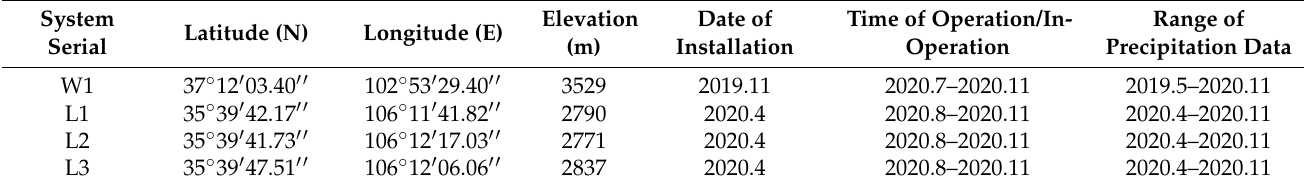
Table 1. Information about the ground-based negative ionization systems.